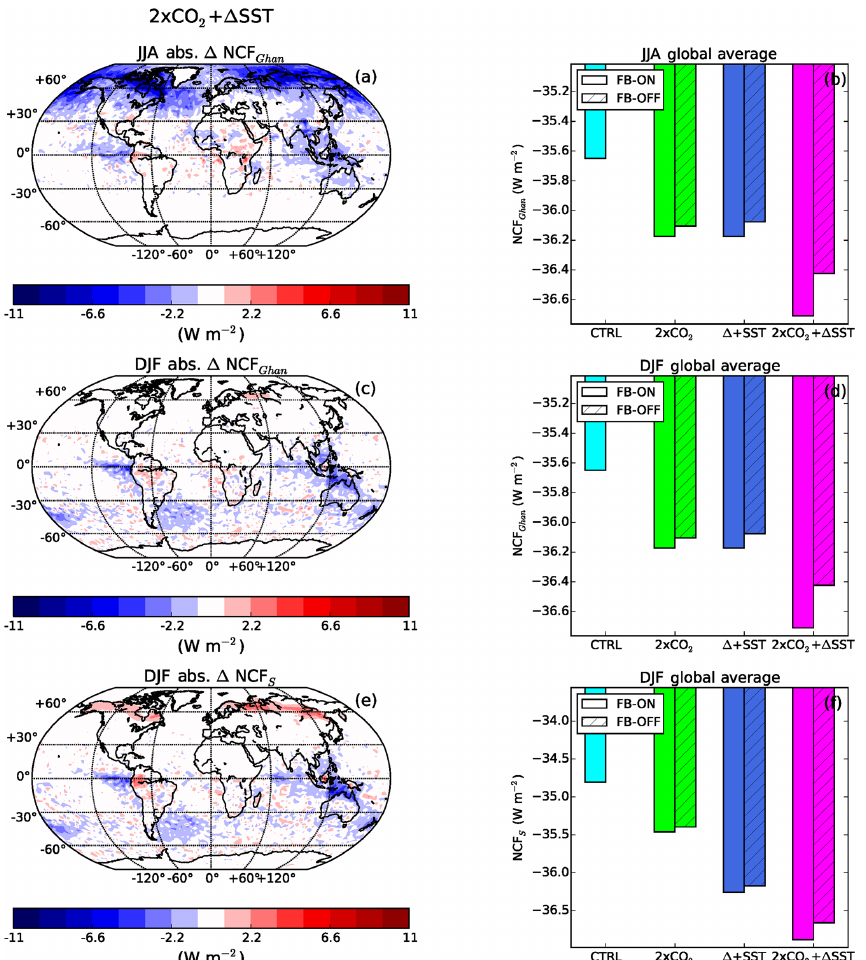
Figure 8. The absolute difference between the FB-ON and FB-OFF simulations for the NCF Ghan during June, July and August (a) , December January and February (c) , as well as the NCF S during December, January and February (e) for the 2 × CO 2 + (cid:49) SST experiment. In the bar plots (b, d, f) , the globally averaged values of the same variables are shown for the CTRL simulation as well as the three experiments (both FB-ON and FB-OFF